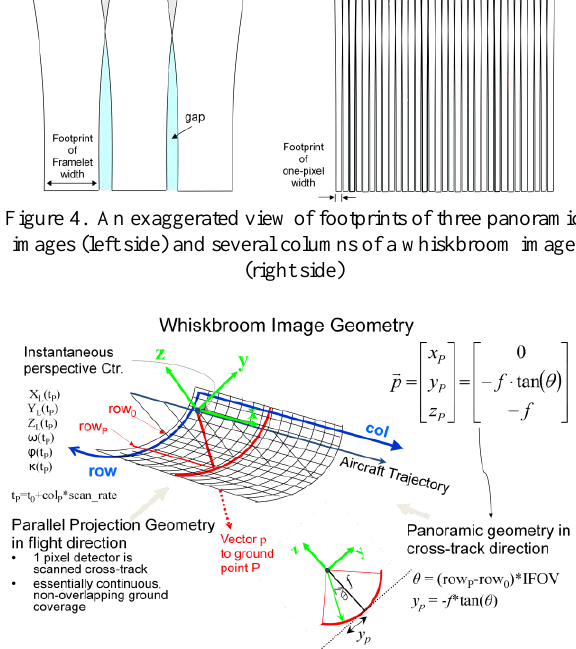
Figure 5. Whiskbroom geometry applied to a GH UAV scene